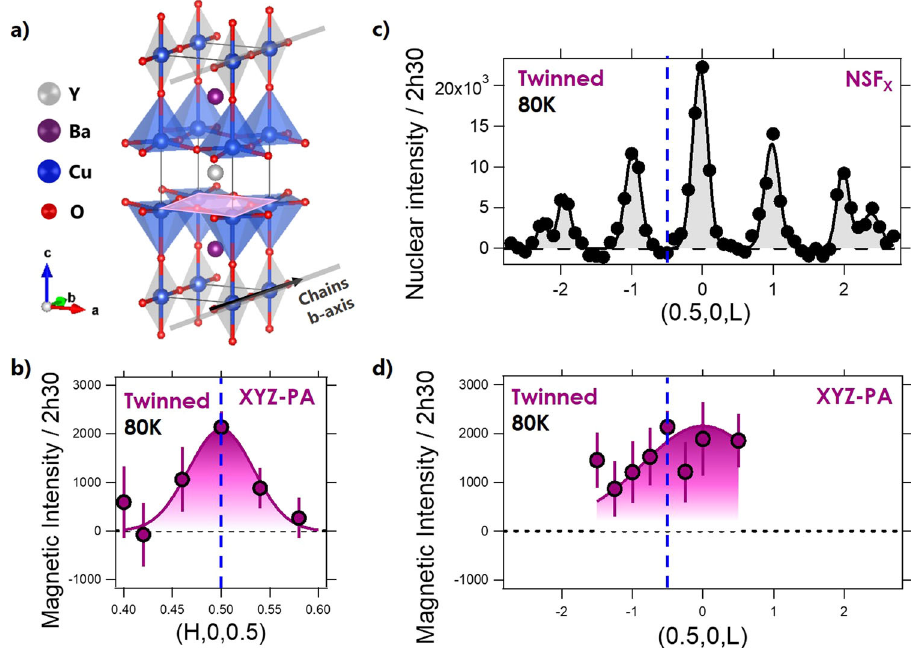
Fig. 1 Commensurate magnetism in twinned YBa 2 Cu 3 O 6.6 (YBCO-t). a Crystal structure of YBa 2 Cu 3 O 6 + x with the CuO chains running along the b-axis (gray shaded arrow) and the CuO 2 planes represented by the pink shading. b Scan in momentum space along the H direction across (0.5,0,0.5) showing the magnetic scattering extracted from XYZ polarization analysis (XYZ-PA). The magnetic scattering is fi tted by a Gaussian line centered at (0.5,0,0.5). c Background subtracted scan in momentum space along the (0.5,0, L ) direction in the non-spin- fl ip (NSF X ) channel. The peaks in the NSF X channel correspond to nuclear scattering from the Ortho-II oxygen chains superstructure. d Q-dependence of the magnetic intensity along the (0.5,0, L ) trajectory as extracted from full XYZ-PA in YBCO-t. Data in b – d were measured on 4F1 at 80K with the sample aligned in the (1,0,0)/(0,0,1) scattering plane. Lines are fi ts by a sum of Gaussian peaks to the data. Error bars represent one standard deviation. Raw data are given in Supplementary Fig.